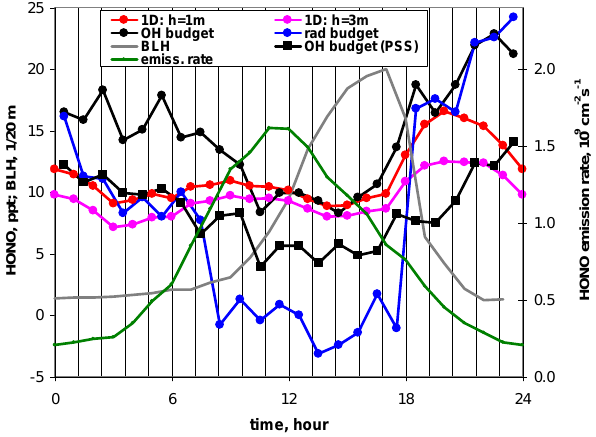
Figure 10. Comparison of median diurnal profiles of [HONO] de- rived from OH (black) and sum of radicals (OH and RO 2 ) (blue) budgets with [HONO] calculated with 1-D model at the heights of 1m (red) and 3m (magenta) for the days 2–9 of January. Black cir- cles and squares correspond to [HONO] derived using measured and calculated steady-state [NO 2 ], respectively. Grey and green lines represent modelled median boundary layer height and HONO emission rates,